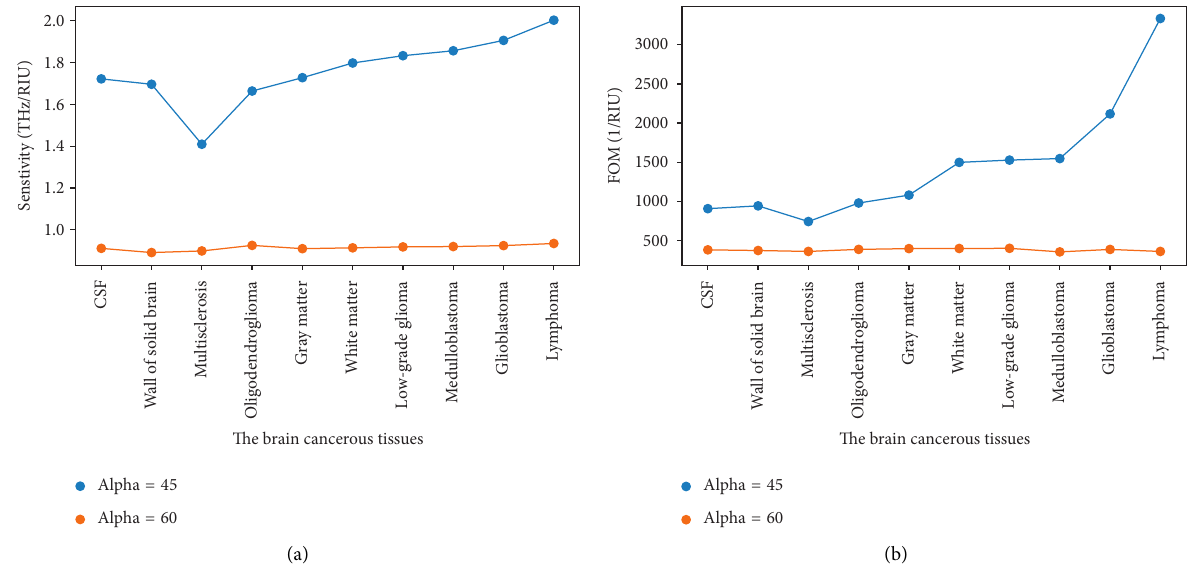
Figure 11: The sensitivity (a) and FOM (b) for different brain cancerous cells at different incident angles. Table 4: The sensitivity comparison of the proposed structure and the latest relevant